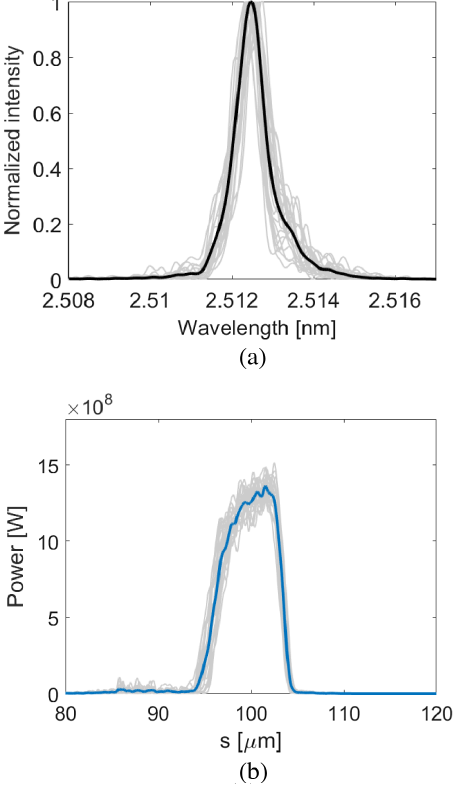
FIG. 10. (a) Output spectrum profiles at the end of the radiator (gray lines represent the 38th – 70th passes, and the black line represents the average spectrum over the 38th – 70th passes). (b) Output power profiles at the end of the radiator (gray lines represent the 38th – 70th passes, and the blue line represents the average power over the 38th – 70th passes).